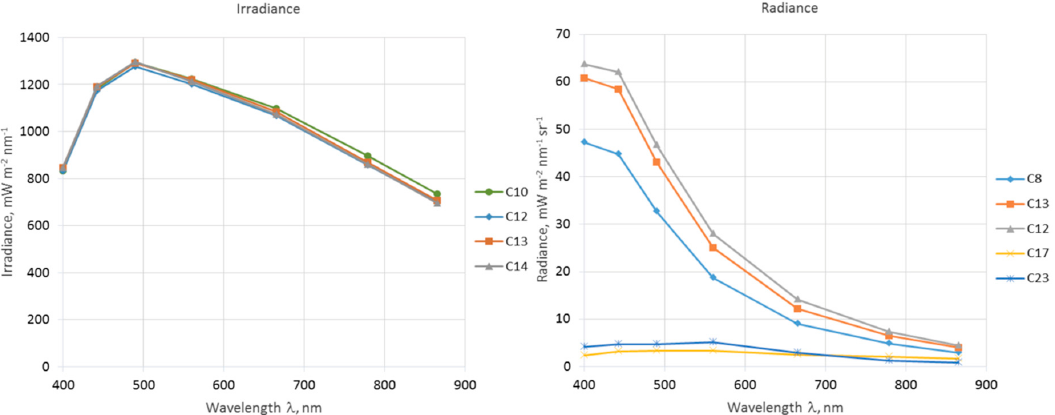
Figure 11. Irradiance and radiance consensus values in the outdoor experiment. C8, C10, C12, C13, C14—blue sky (radiance) or direct sunshine (irradiance); C17—water in cloud shadow; C23—sunlit water. Reproduced with permission from [46].